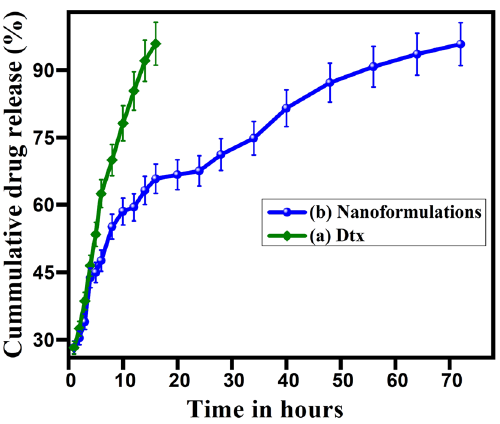
Figure 9. In vitro drug release profile of ( a ) docetaxel and ( b ) gold nanoformulations in PBS solution at pH